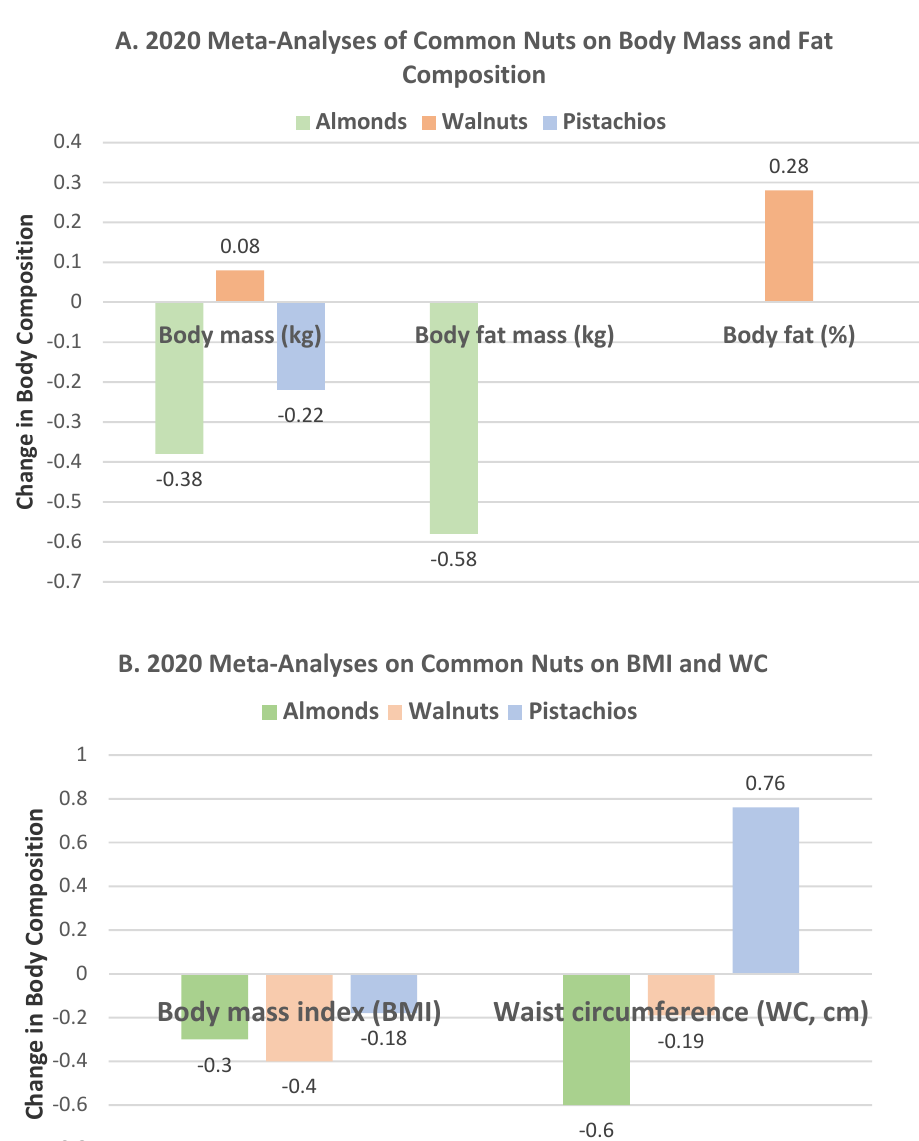
0.76 cm ( − 0.11, 1.63 cm, p = 0.087). The researchers concluded that “a diet with